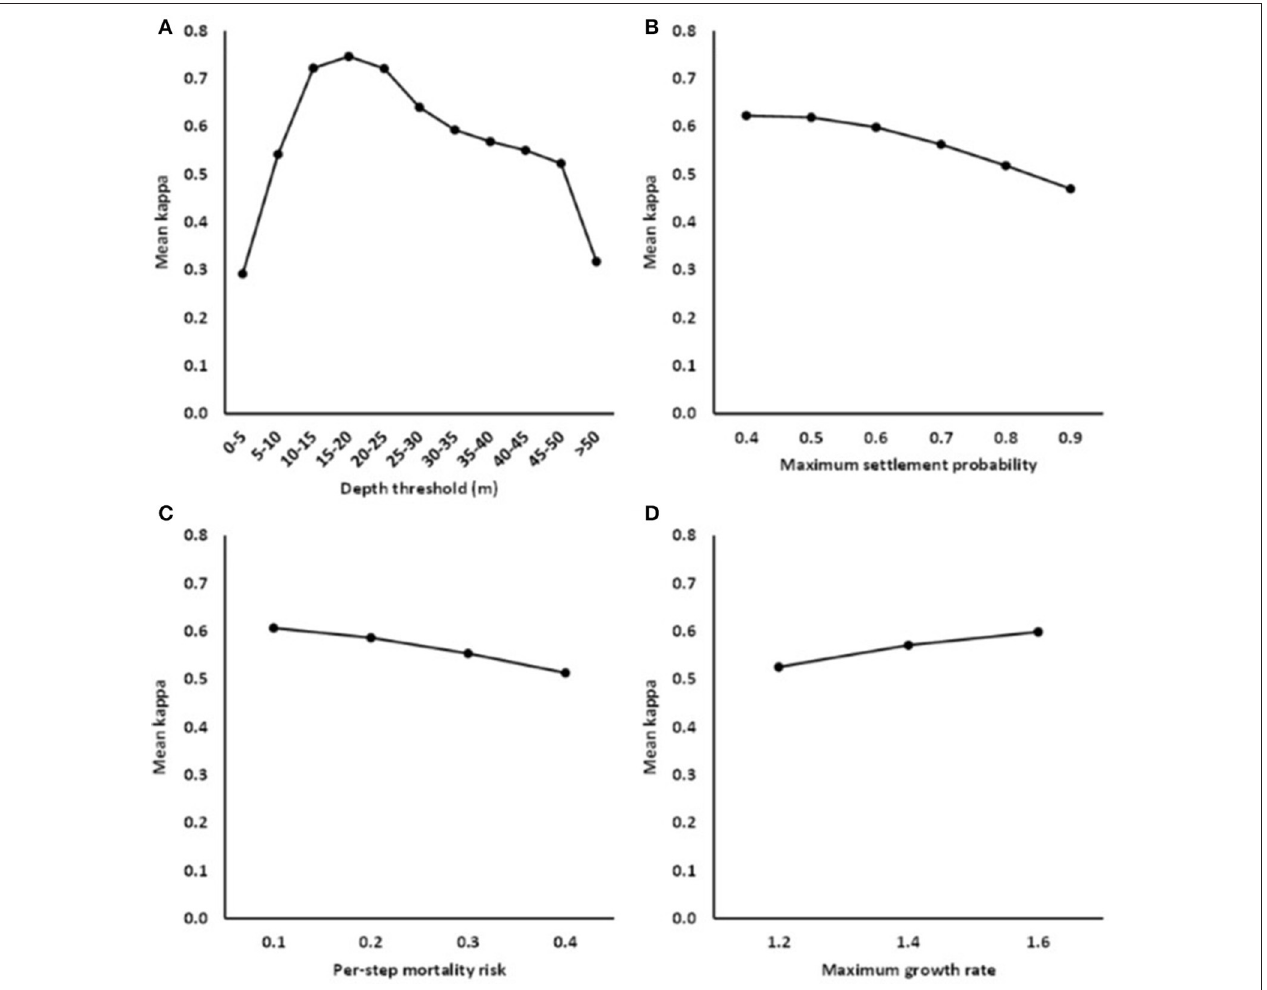
FIGURE 2 | Fit of the RangeShifter model for the Gulf of Gdansk: marginal mean values of κ (kappa) in relation to (A) the depth threshold class, (B) the maximum settlement probability, (C) the risk of mortality at each step taken during dispersal, and (D) the maximum population growth rate.